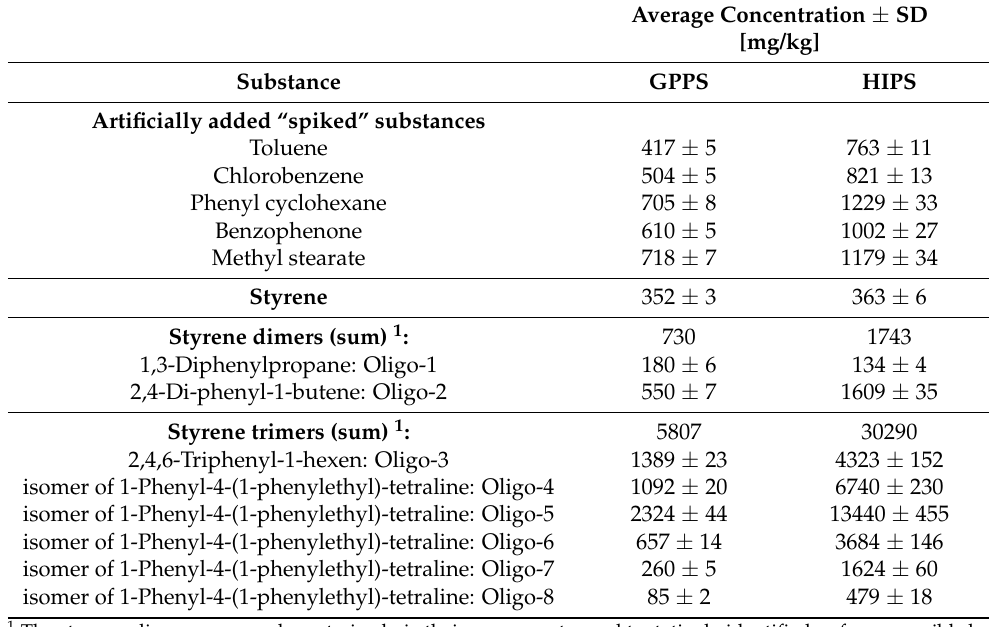
Table 1. Average initial concentration ( C p ,0 ) of the model spiked substances and residual content of styrene monomer and oligomers in the investigated polystyrene (GPPS and HIPS) sheets ( ± standard deviation of triplicate analysis).